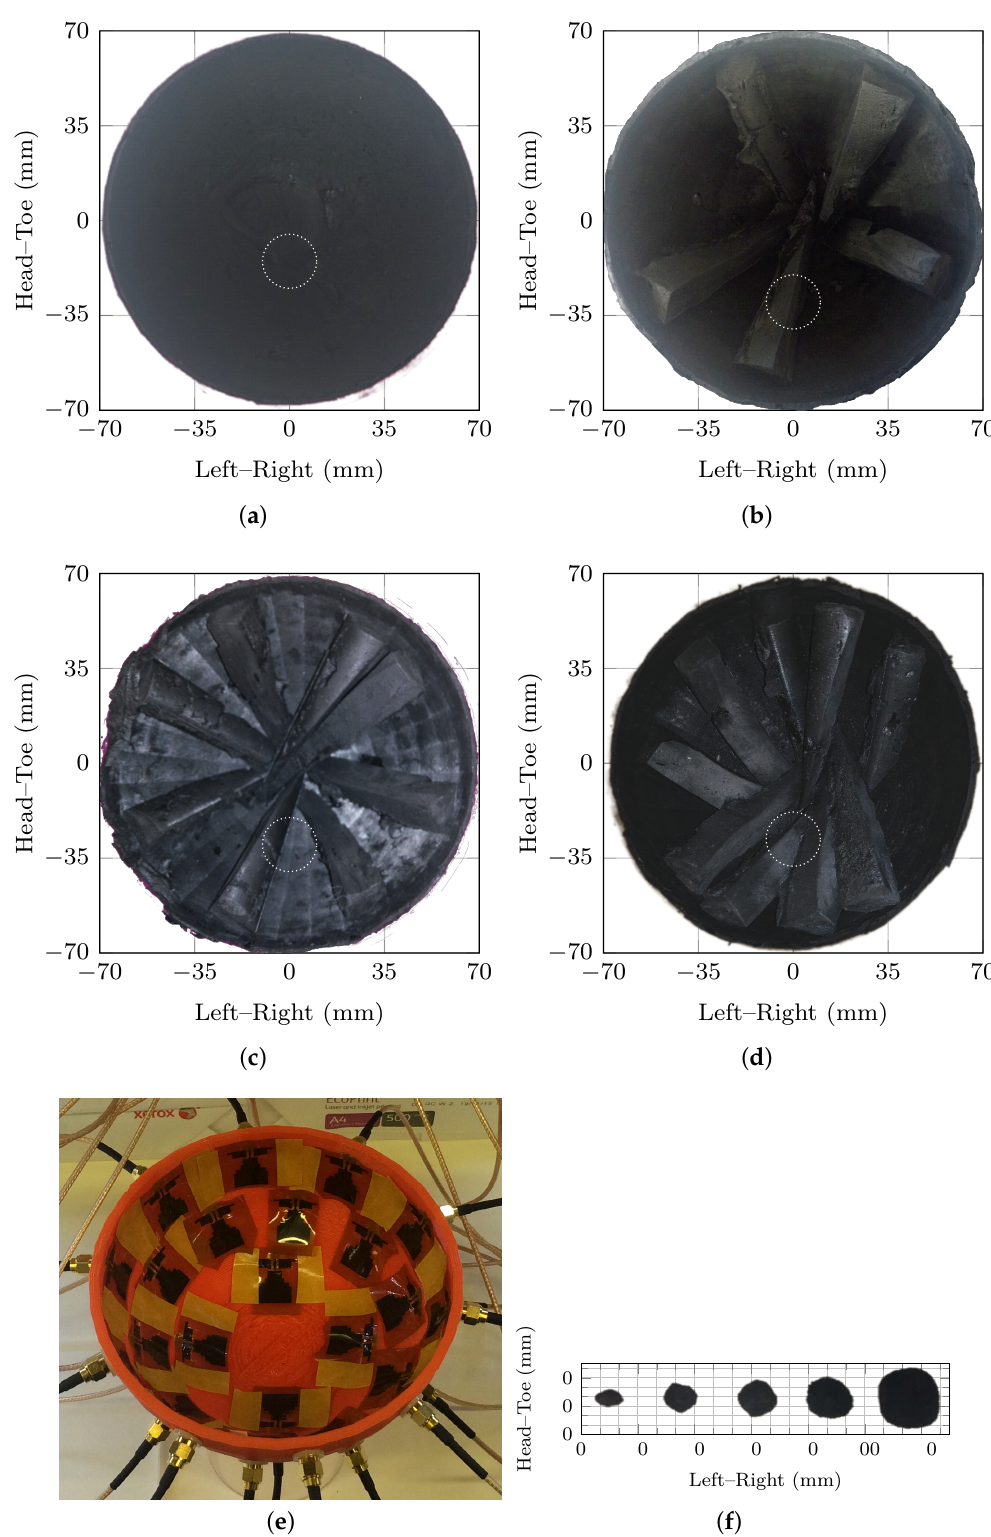
Figure 1. The four breast phantoms are shown in ( a – d ) containing 0%, 10%, 15% and 20% VGF, respectively. The tumor location is shown by the dashed, white circle. The 24 flexible microstrip antennas shown housed in the radome are shown in ( e ) and the 5 tumour phantoms are showin in ( f